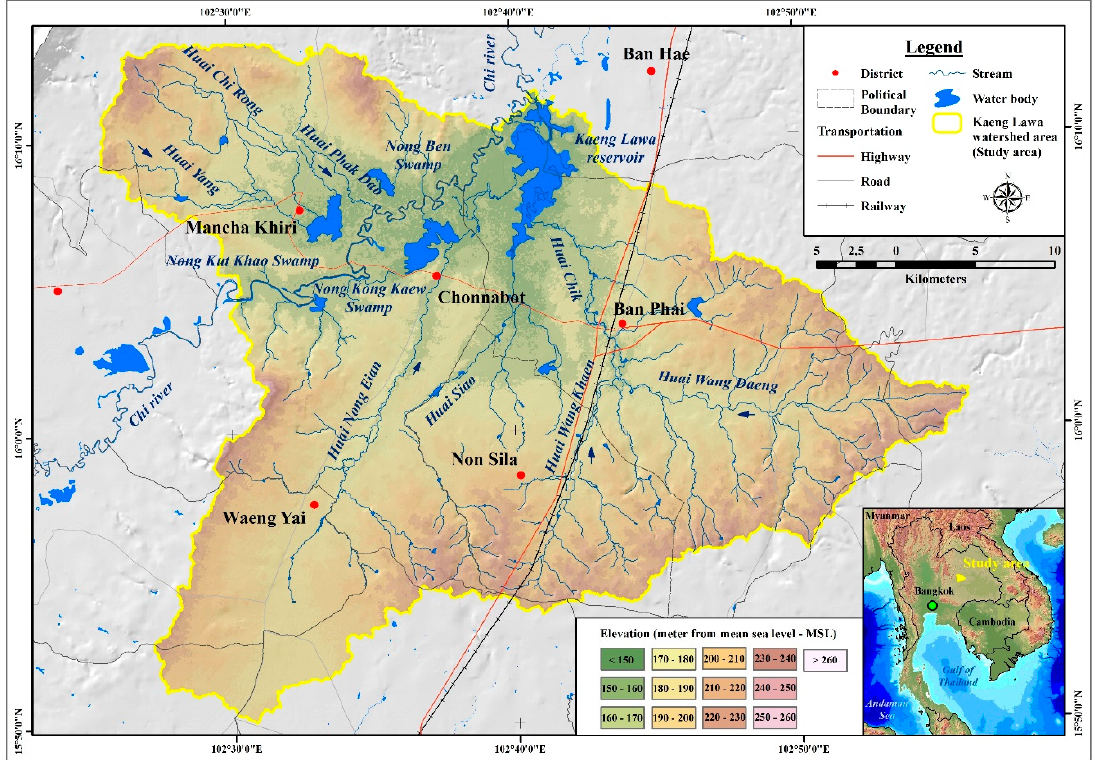
Figure 1. Geographical setting of the study area of the KLs area.